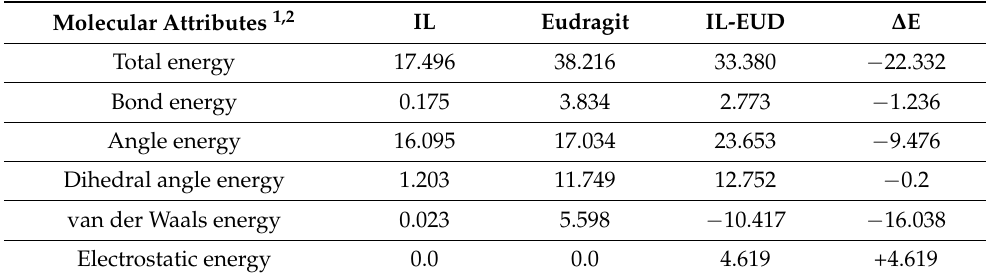
Table 3. Molecular attributes for the IL-polymer in silico complex in